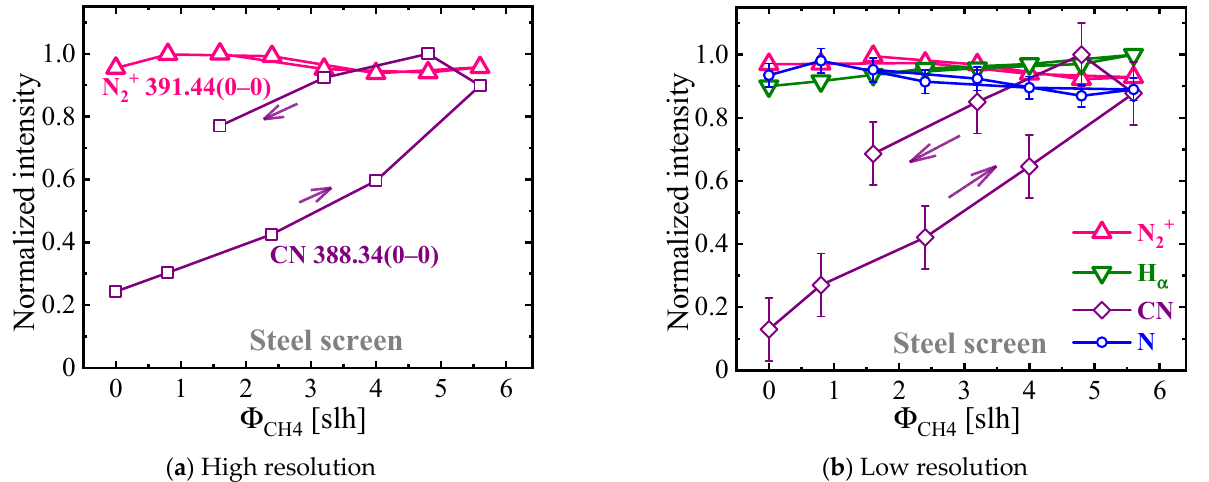
Figure 4. Development of peak intensities with variation of CH 4 admixture level recorded with high- ( a ) and low- resolution ( b ) spectrometers during ASPNC treatment using a steel AS at H 2 :N 2 = 1:1, p = 3 mbar, T = 460 °C, Φ Total = 80 slh, and P Bias = 1.25 kW. Lines are guides for the eye and arrows indicate the order of measurements.